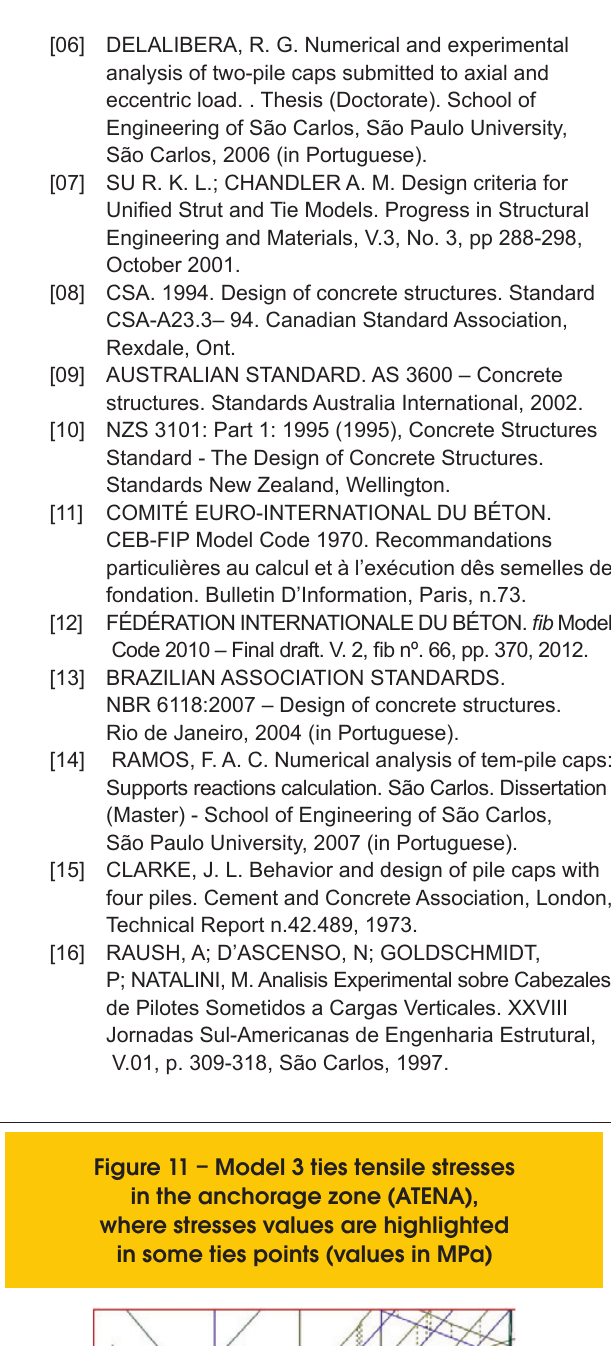
Figure 10 – Model 2 ties tensile stresses in the anchorage zone (ATENA), where stresses values are highlighted in some ties points (values in MPa)